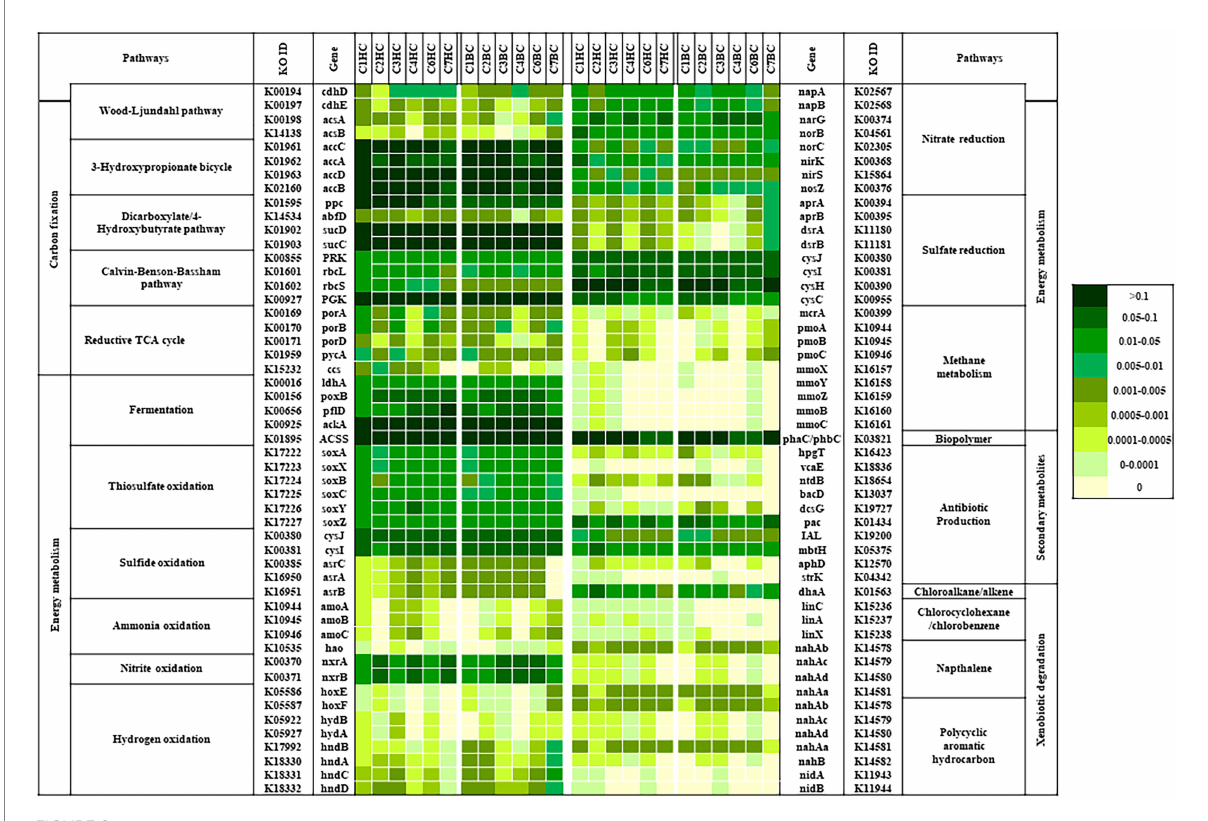
FIGURE 8 Relative abundance of predicted genes related to CO 2 fixation pathway, lithotrophy related/energy metabolism and genes related to other important metabolism (amongst metabolic genes) as predicted by PICRUSt